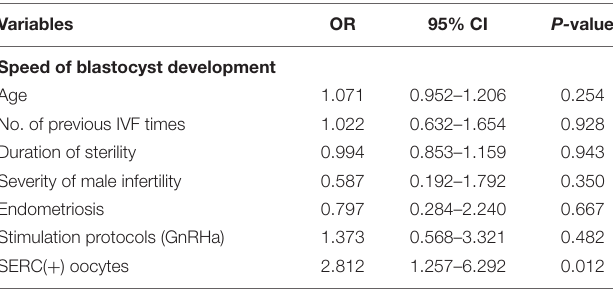
TABLE 4 | Logistic regression analysis of SERC in oocytes that may affect the speed of blastocyst development.